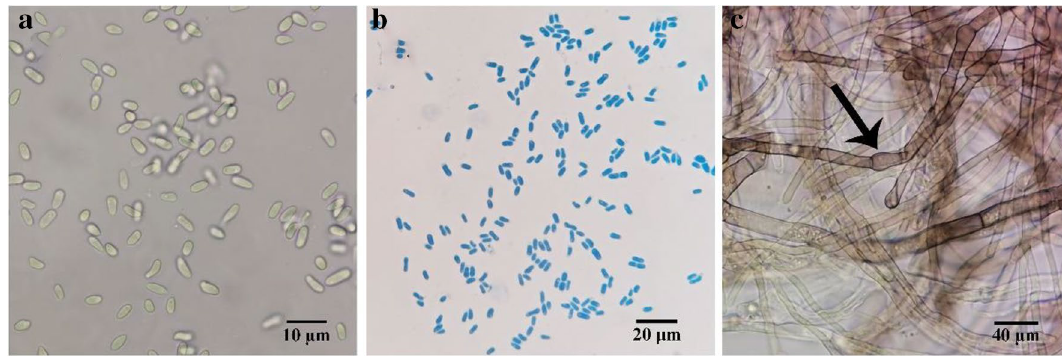
Figure 3. Morphological characteristics of the pathogen cultured in the PCA at 25 °C for 20 days. ( a,b ) conidia and ( c )